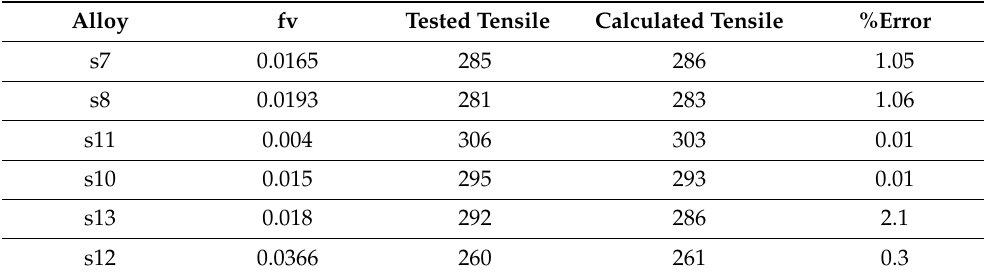
Table 9. Comparison of Calculated and Tested Tensile Test Values in 1 mm/min Stroke Speed.